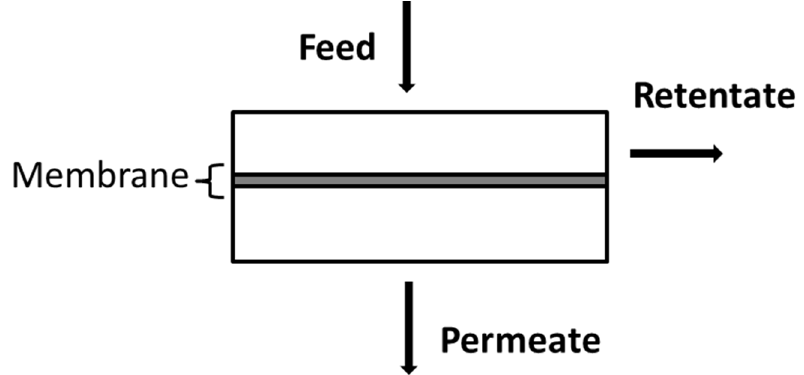
Figure 14. Module illustration of a membrane